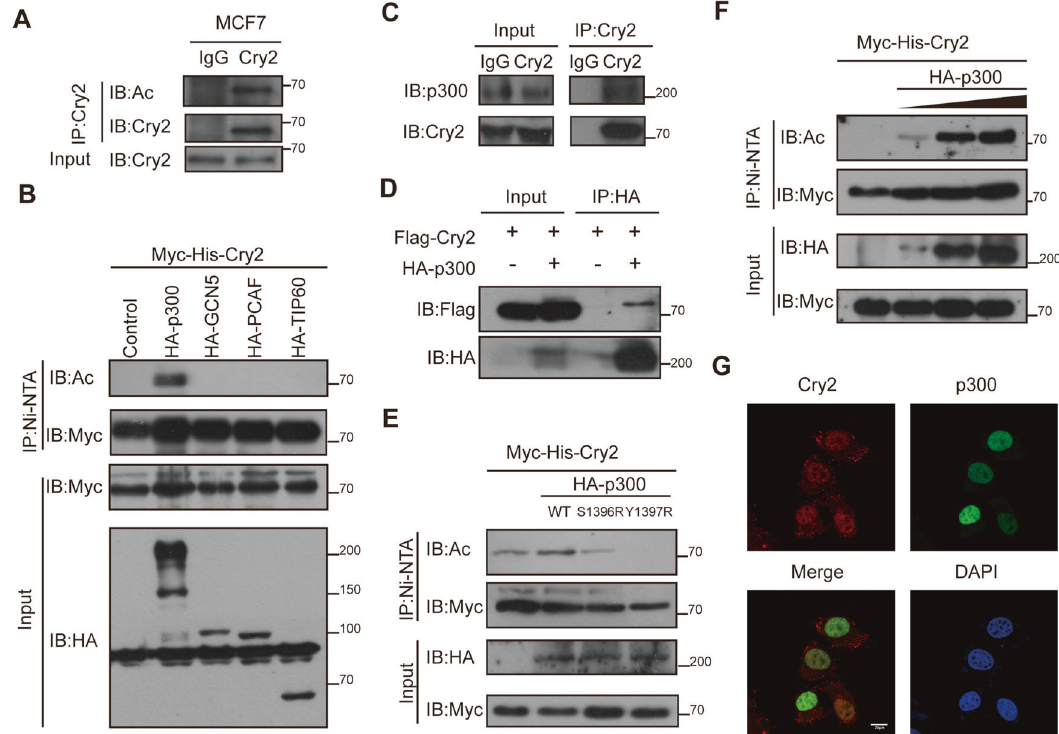
Fig. 1 Cry2 is a substrate of acetylation which is driven by p300. A Endogenous Cry2 is targeted by acetylation in MCF7 cells. B p300 promoted Cry2 acetylation in HEK293T cells. C Endogenous interaction between Cry2 and p300 in MCF7 cells. D Exogenous interaction between Cry2 and p300 in HEK293T cells. E p300 promoted Cry2 acetylation depend on its KAT activity. F p300 promoted Cry2 acetylation in a dose-dependent manner. G Cry2 and p300 were colocalized in the nucleus in MCF7